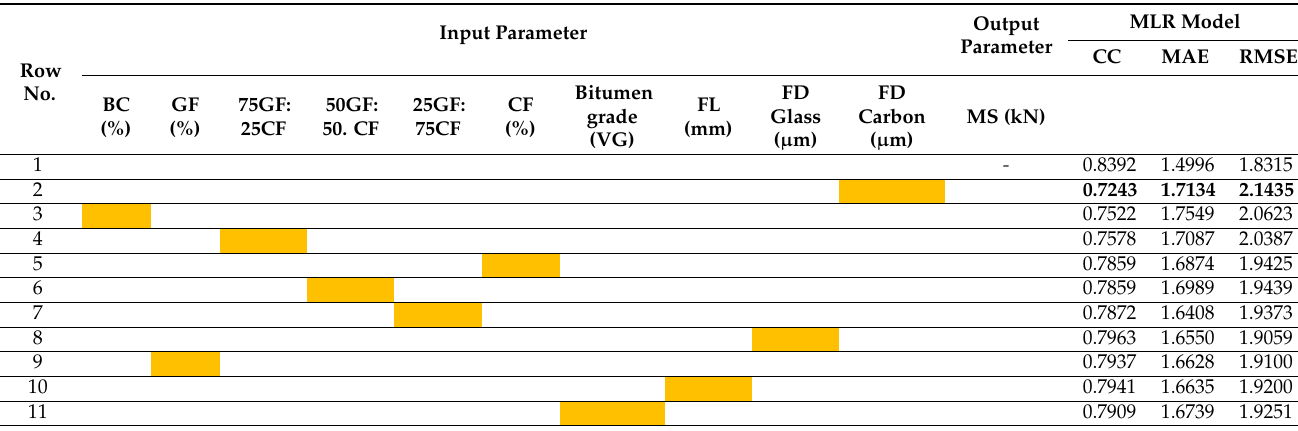
Table 14. Feature importance analysis (MLR